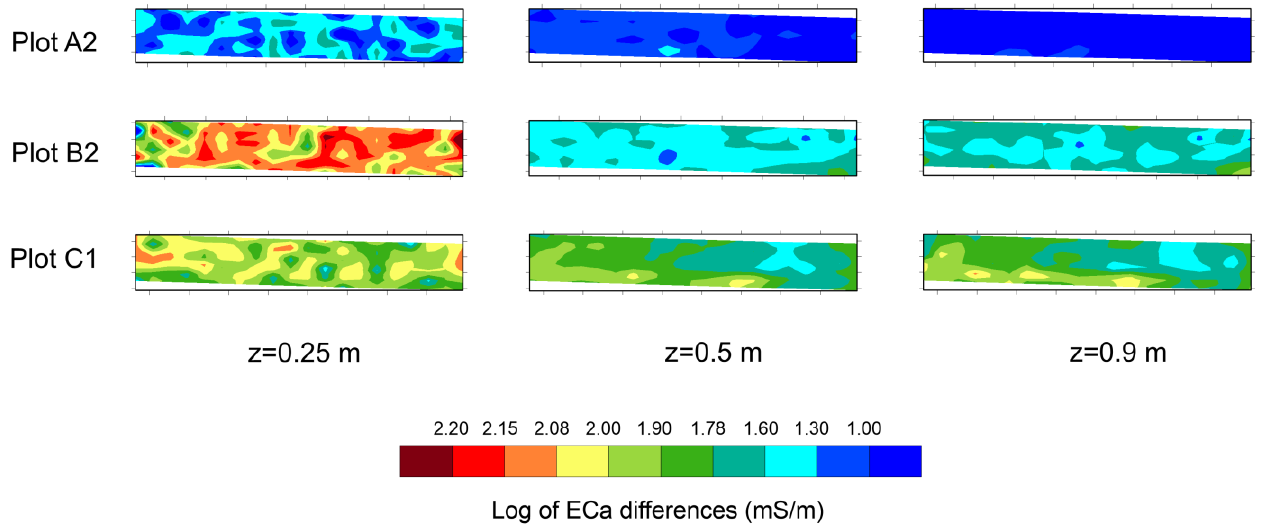
Figure 9. Differences in ECa values computed by comparing the last EMI dataset (15 September) and the first one (26 June). the first one (26 June).